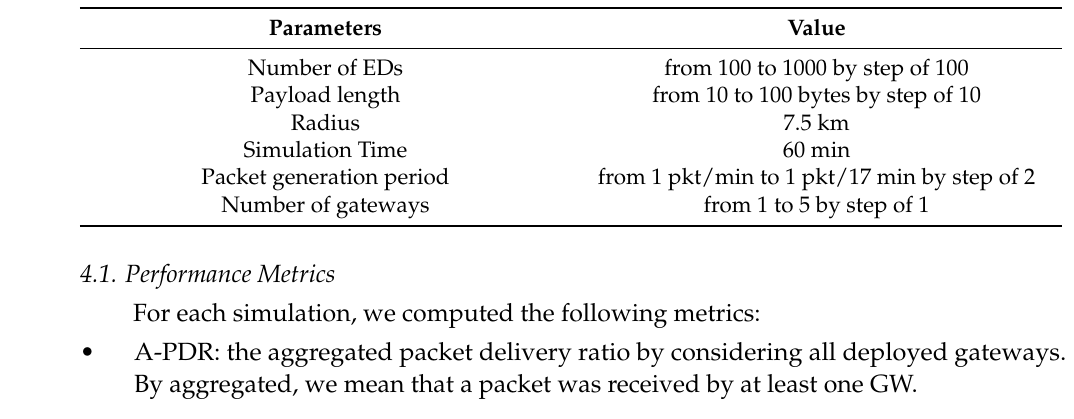
Table 3. Simulation